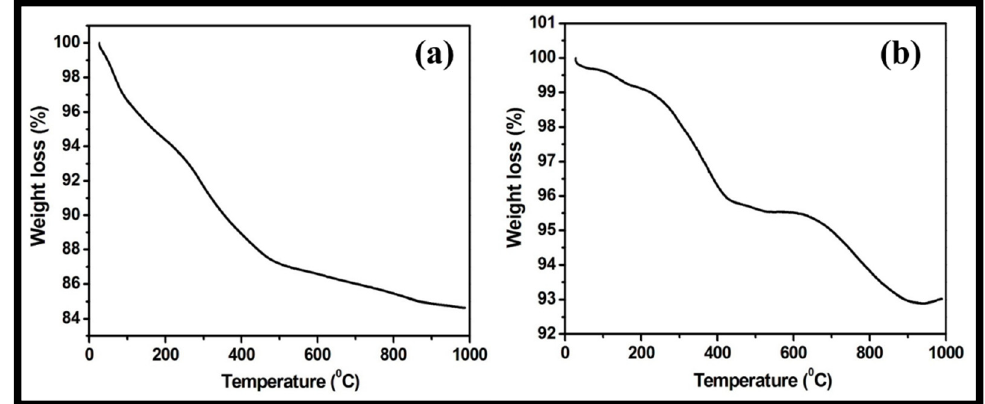
Figure 8. Typical TGA thermograms of ( a ) WO 3 nanorods and ( b ) rGO-WO 3 heterostructure.